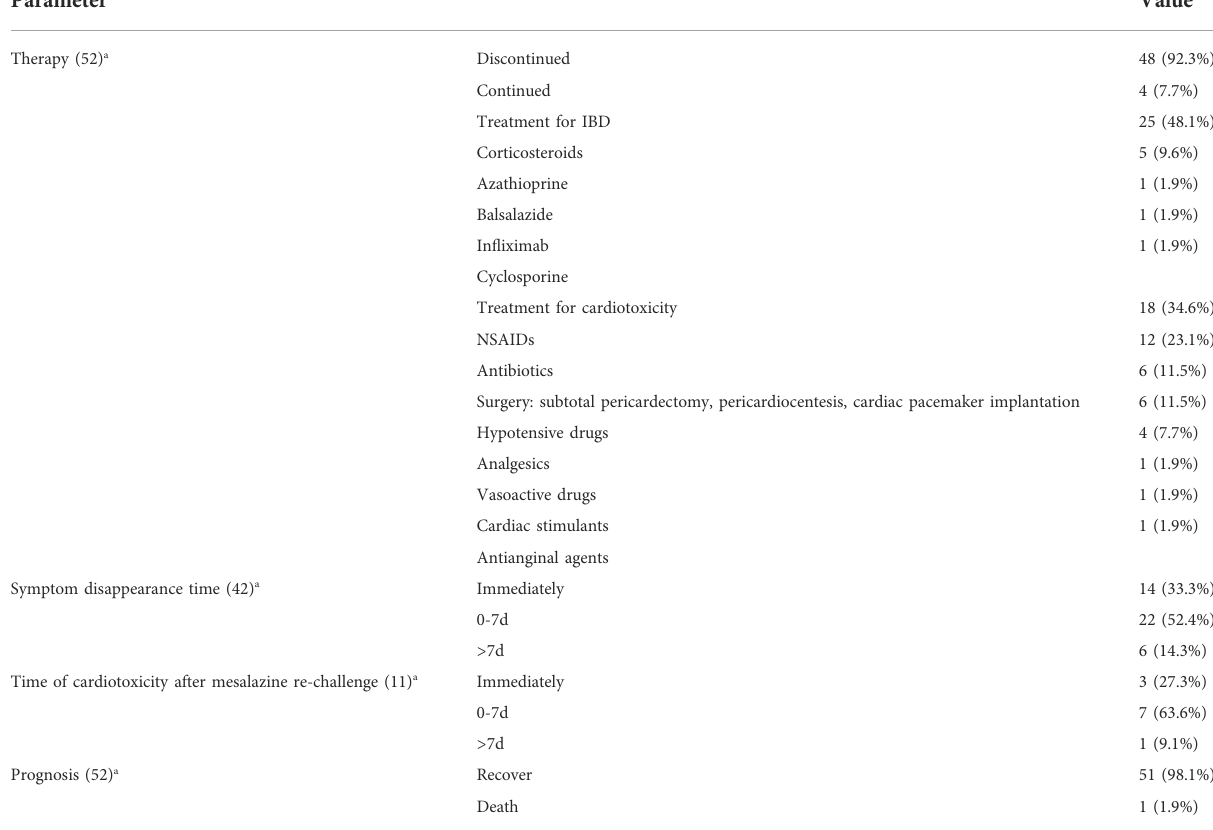
TABLE 4 Treatment and prognosis of 52 patients reported in case